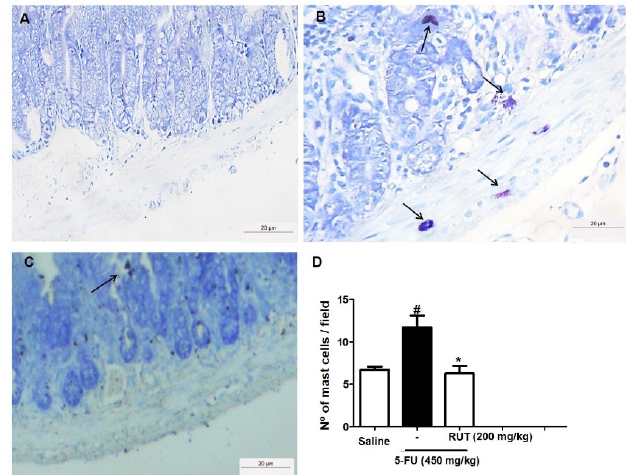
Figure 9. Mast cell counts in the jejunal segment based on Toluidine Blue staining. Saline ( A ); 5-FU ( B ); RUT-200 ( C ); Statistical representation of experimental groups ( D ). Black arrows indicate mast cells. All the panels were obtained at 400 × magnification. Values are presented as mean ± SEM of the number of mast cells per field. For the statistical analysis, one-way ANOVA was used, followed by Tukey’s test. # p < 0.05 in 5-FU vs. Saline group; * p < 0.05 in RUT-200 vs. 5-FU group. 5-FU, 5-fluorouracil; RUT,